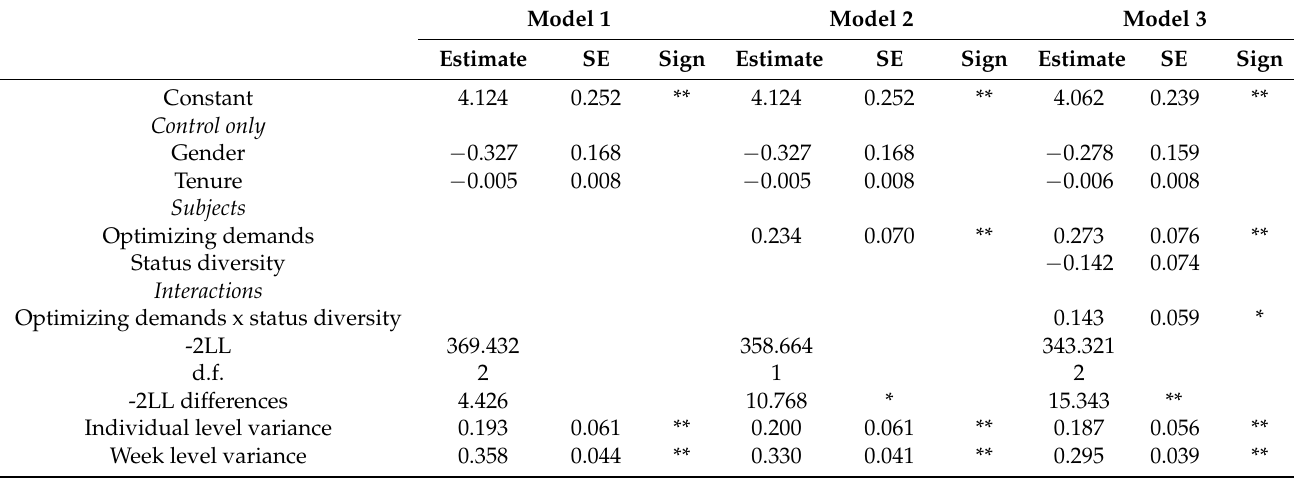
Table 5. Multilevel estimates of weekly optimizing demands, perceived work group member status diversity on weekly creativity.